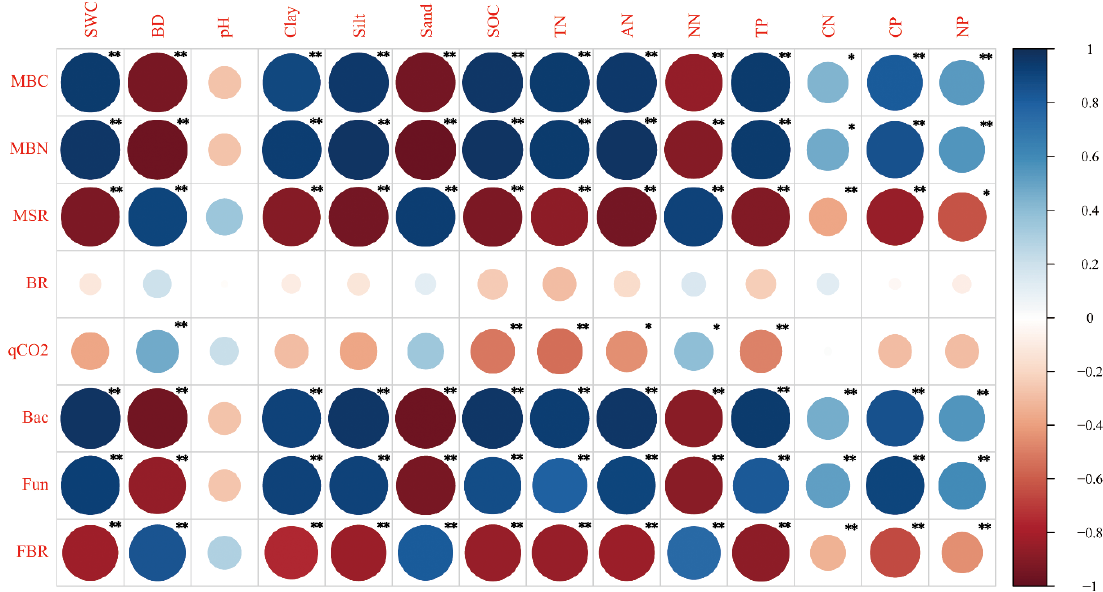
Figure 6. Correlation analysis between microbial properties and soil physical chemical properties in October. SWC, soil water content; BD, soil bulk density; Clay, soil clay content; Silt, soil silt content; Sand, soil sand content; SOC, soil organic carbon; TN, total nitrogen content; AN, ammonium nitrogen content; NN, nitrate nitrogen content; TP, soil total phosphorus content; CN, soil C:N ratio; CP, soil C:P ratio; NP, soil N:P ratio; MBC, microbial biomass carbon; MBN, microbial biomass nitrogen; MSR, MBC:SOC ratio; BR, basal respiration; qCO2, microbial metabolic quotient; Bac, bacteria abundance; fun, fungi abundance; FBR, fungi:bacteria ratio. * p < 0.05, ** p < 0.01.